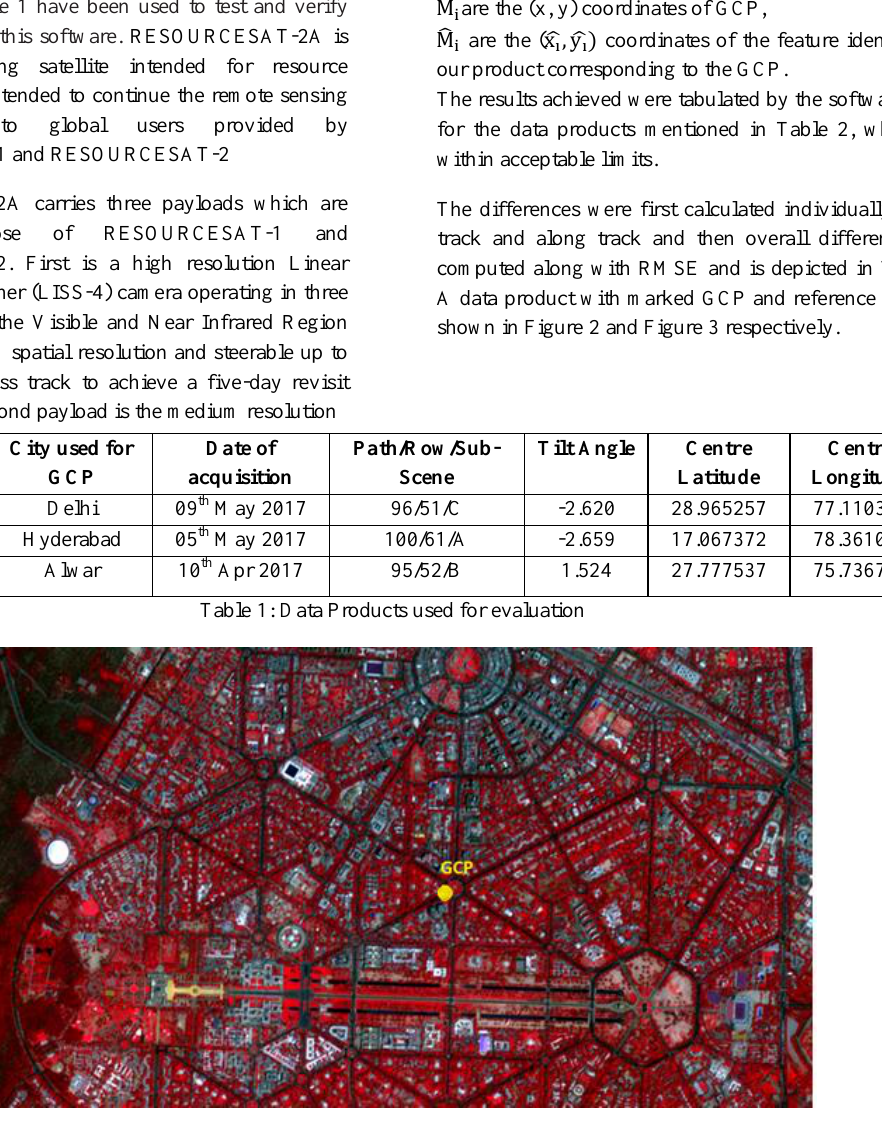
Figure 2. RS2A L4FMX Data Product